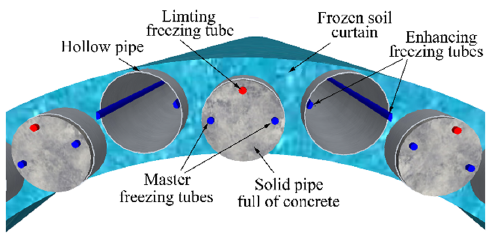
Figure 4. The layout of freezing tubes. Figure 4 . The layout of freezing tubes. Figure 4 . The layout of freezing tubes.